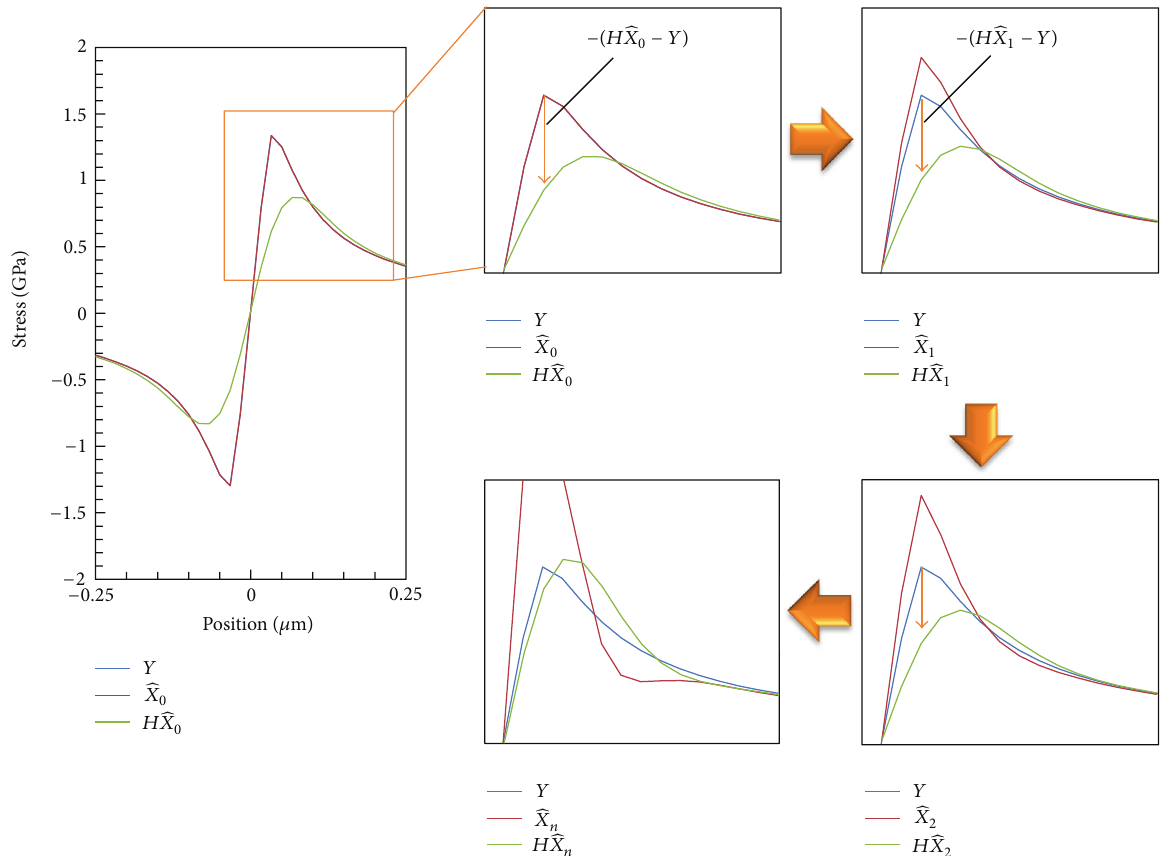
Figure 2: The every steps of the recurrence formula of BTV deconvolution